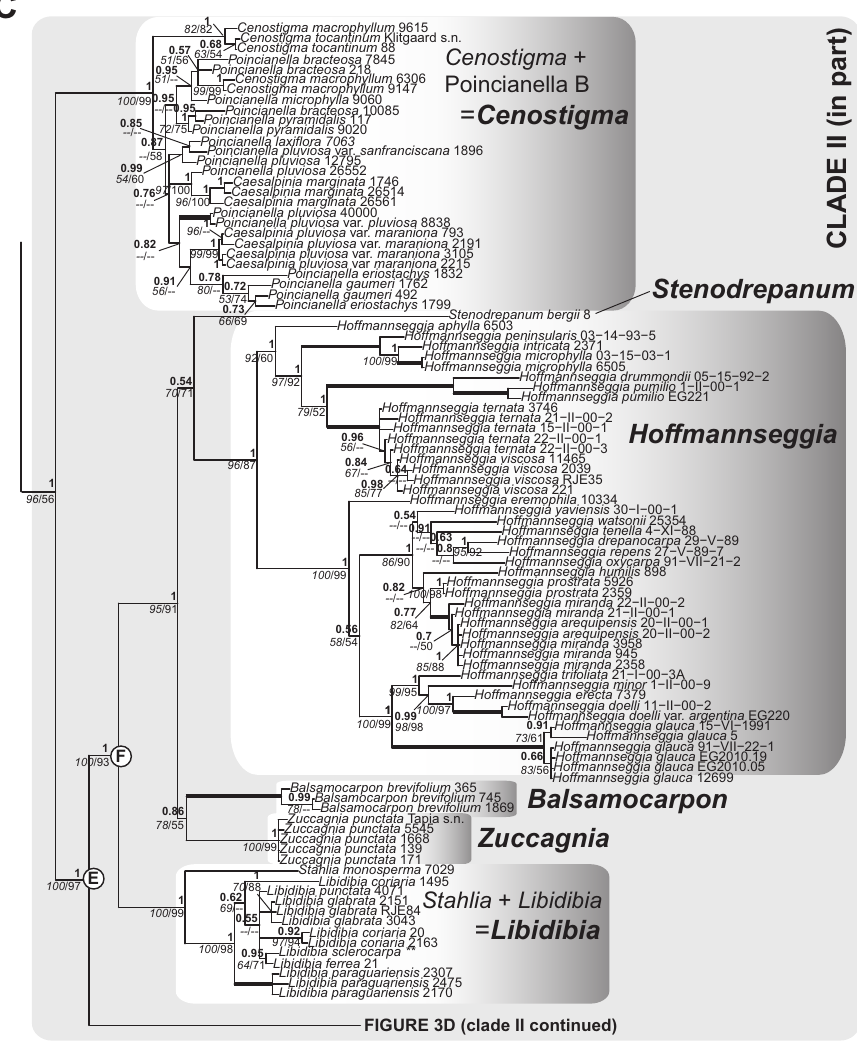
FIGURE 3D (clade II continued)